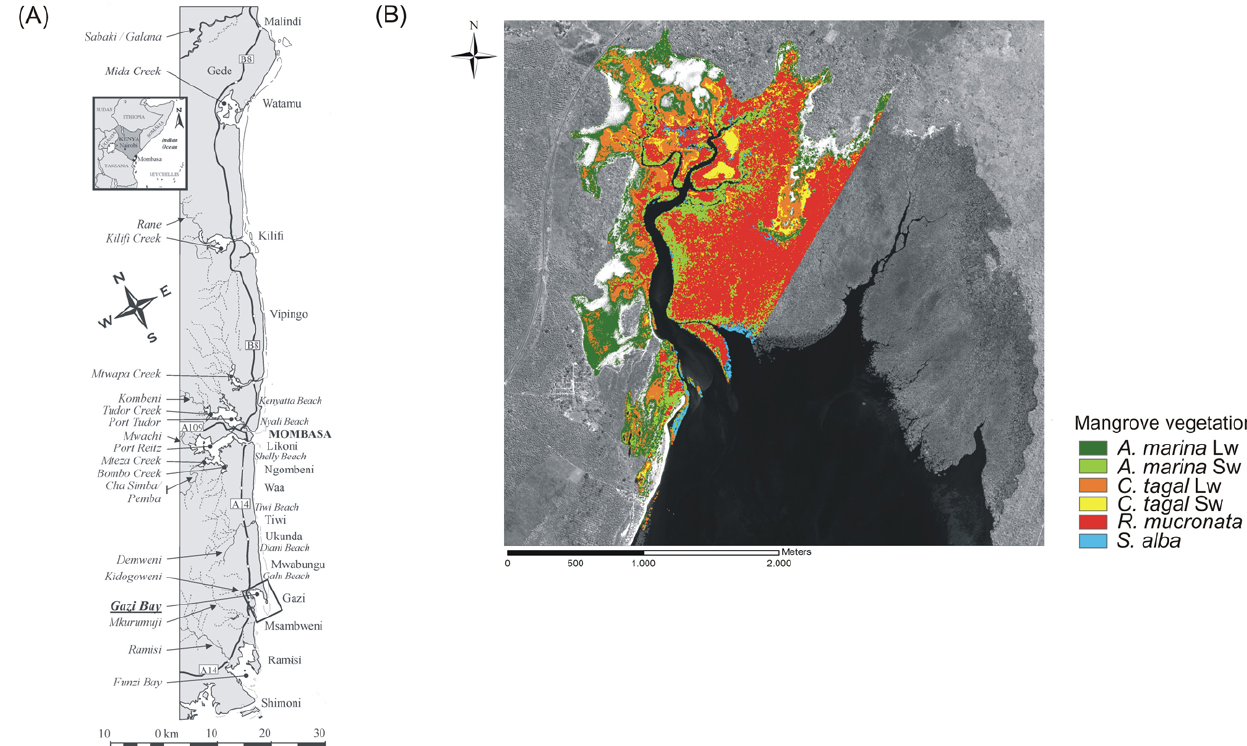
Fig. 1. Representation of (A) the Kenyan coast (Dahdouh-Guebas et al., 2000) and (B) Gazi Bay. The satellite image (QuickBird) shows the whole bay of Gazi ; however this research focuses on the western part as encompassed by the overlaid vegetation map. S. alba = Sonneratia alba , R. mucronata = Rhizophora mucronata , C. tagal Lw = Ceriops tagal on the landward side, C. tagal Sw = Ceriops tagal on the seaward side A. marina Lw = Avicennia marina on the landward side and A. marina Sw = Avicennia marina on the landward side. Classification of the mangrove species coverage was obtained by Neukermans et al.